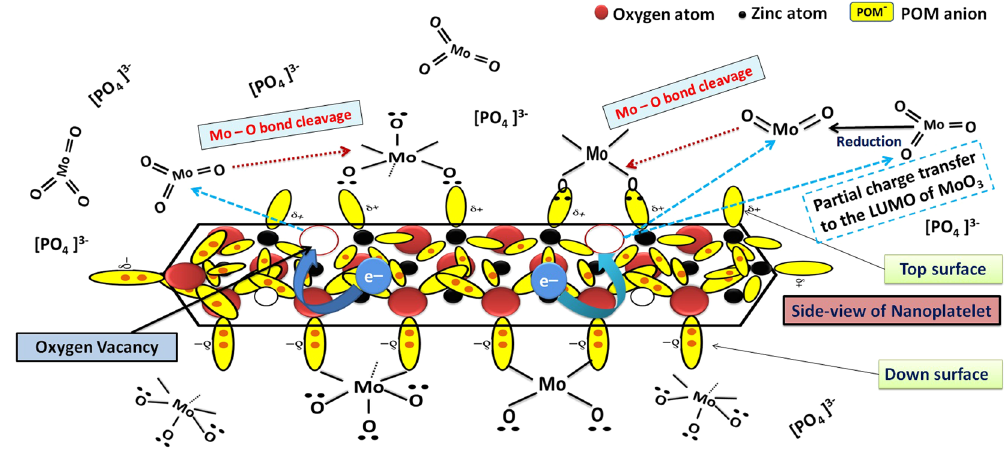
Figure 14. Schematic illustration for the catalytic deposition of Mo 8 O 23 -MoO 2 mixed oxide over ZnO nanoplatelets.